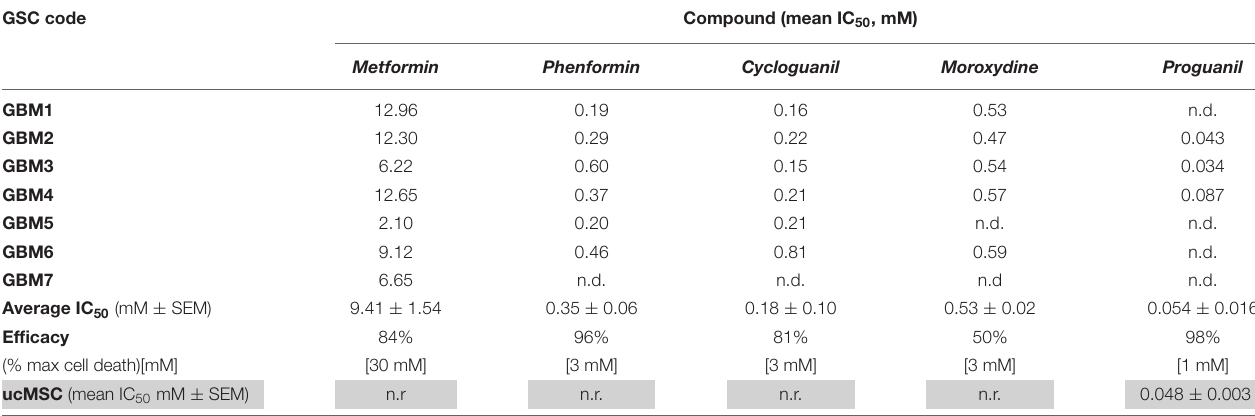
TABLE 2 | IC 50 and efficacy values of the antiproliferative activity of different biguanides on GSC cultures isolated from individual human GBMs.